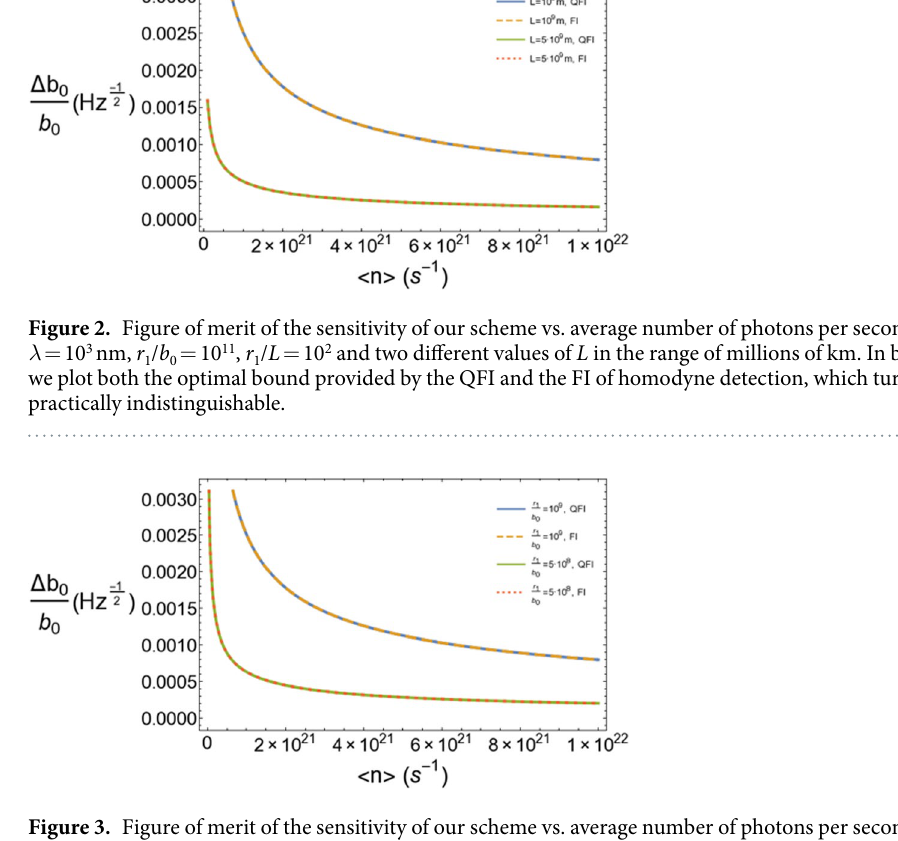
Figure 3. Figure of merit of the sensitivity of our scheme vs. average number of photons per second for = 10 5 , r = 10 8 and two different values of L in the range of λ = 10 3 nm, r 1 / b 0 1 / L